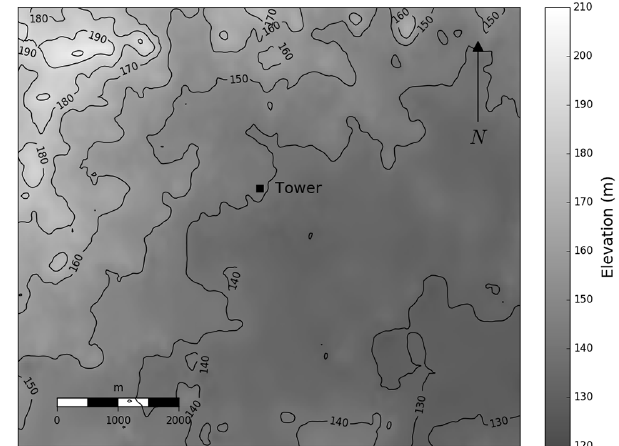
Figure 1. Topography of terrain surrounding